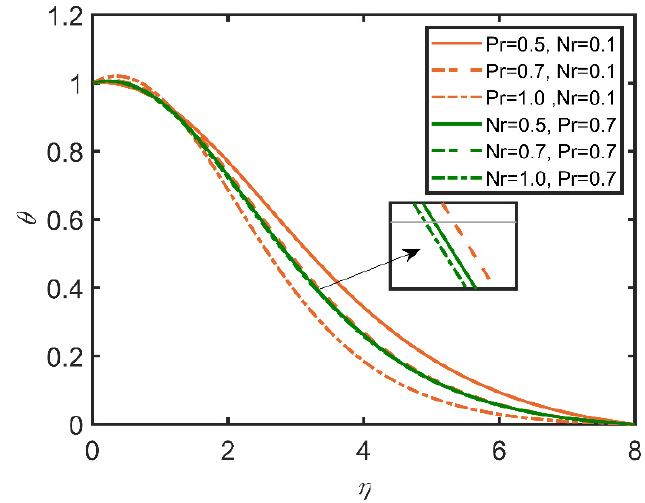
Figure 14. Comparison for temperature profile against 𝜂 .